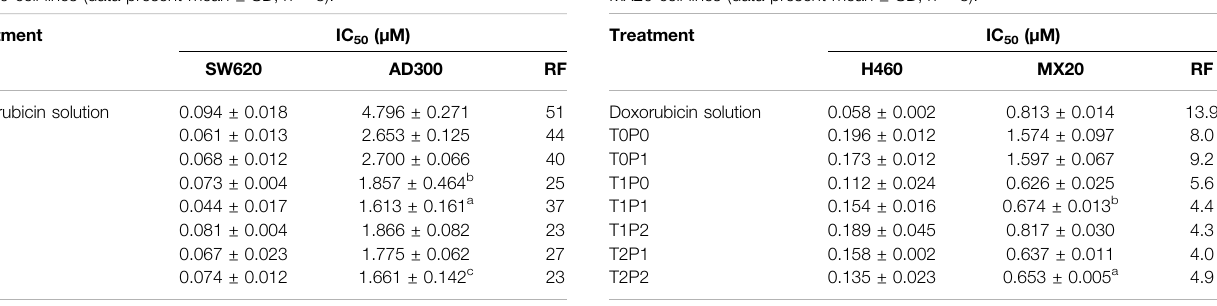
TABLE 3 | The IC50 values calculated from cytotoxicity pro fi les of doxorubicin- loaded PBCA-NPs formulations from MTT assays performed on H460 and MX20 cell lines (data present mean ± SD, n (cid:1)